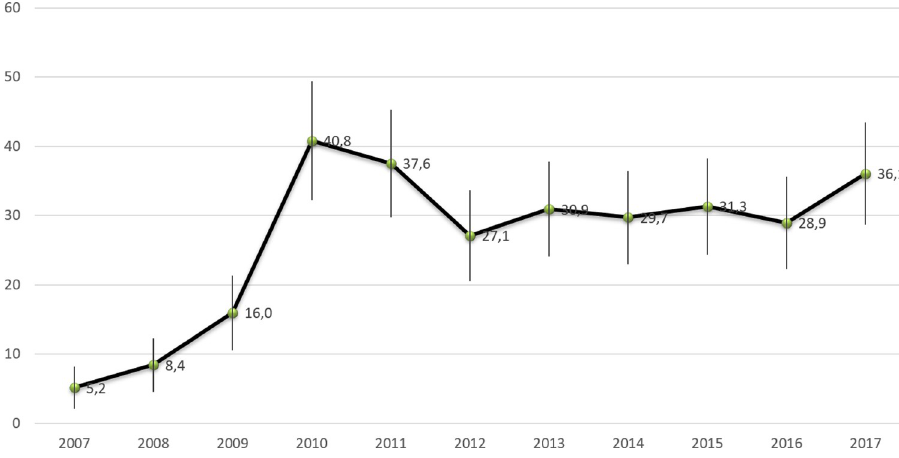
Fig 7. Annual incidence of Q fever in French Guiana between 2007 and